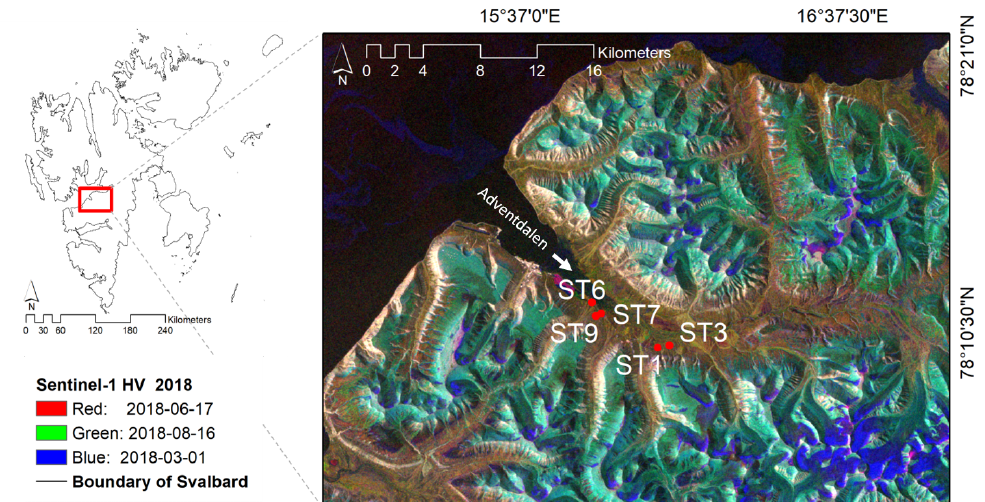
Figure 1. Adventdalen valley and the study area as shown by the Sentinel-1 HV channel in a RGB composition: 17 June 2018 Red band; 16 August 2018 Green band; 1 March 2018 Blue band. The location of the study area on Svalbard (the white arrow points to the Adventdalen valley) and the five selected ground stations are